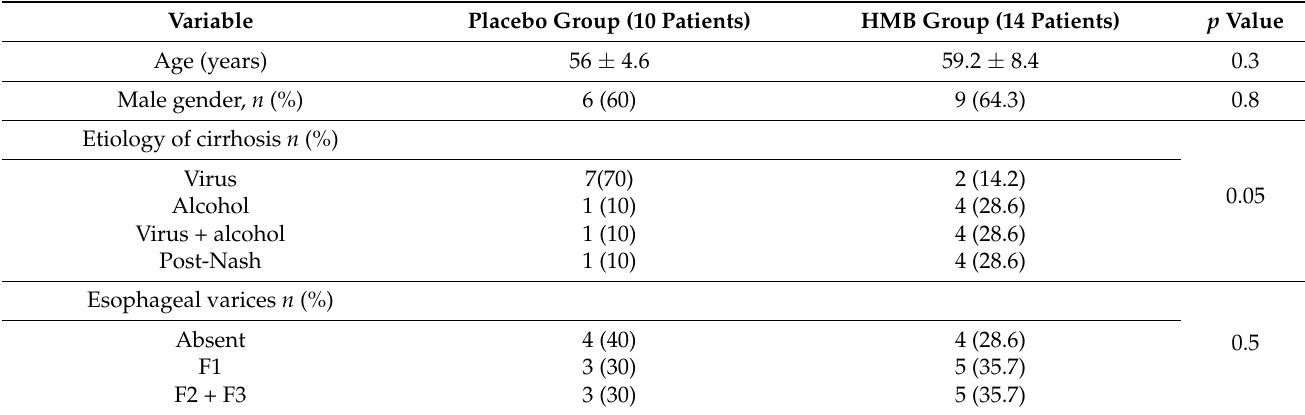
Table 1. Demographic and clinical characteristics of the cirrhotic